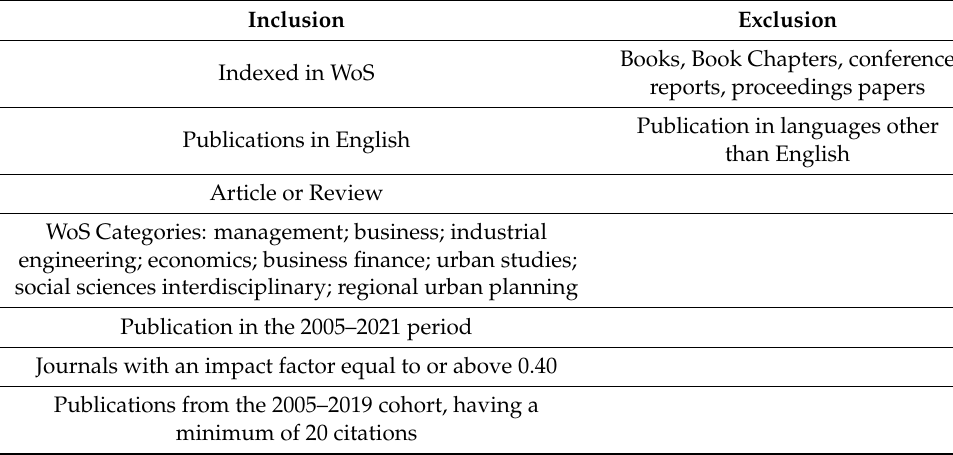
Table 1. Inclusion and exclusion criteria (Source: Own